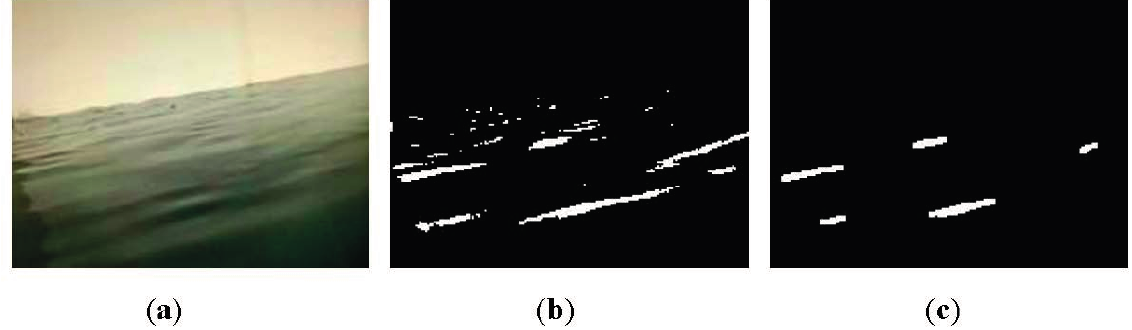
Figure 2. An example of pixel-based detection. ( a ) Original frame; ( b ) Foreground extraction; ( c ) The result with morphological